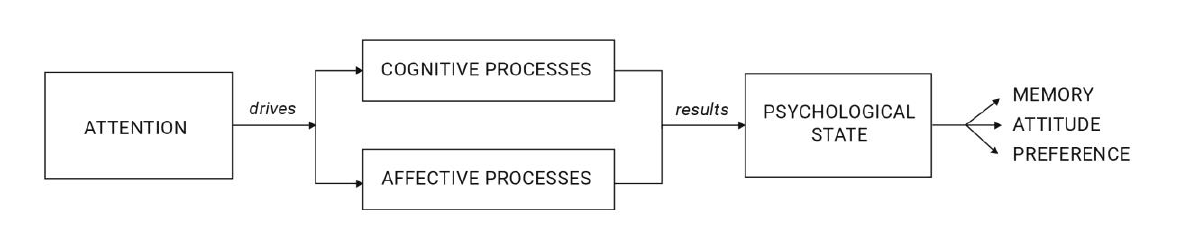
Figure 3. Process model of how attention influences cognitive dimensions and cognitive